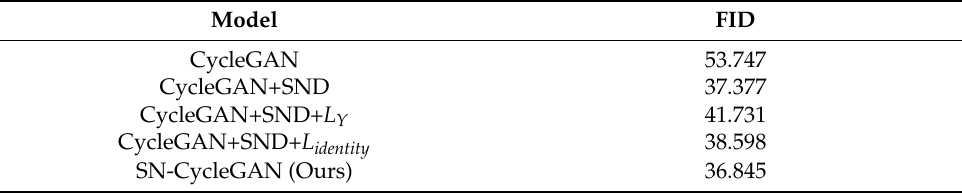
Table 5. Quantitative analysis of ablation experimental